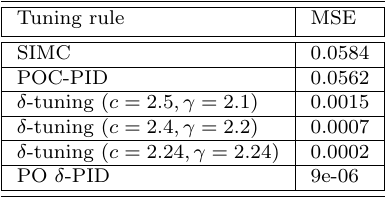
Table 6: Comparing the trade-off curves, generated from different tuning rules, vs. the POI-PID and POC-PID curves, in terms of MSE in Eq. (46). i.e. the trade-off curves shown in Figure 10.